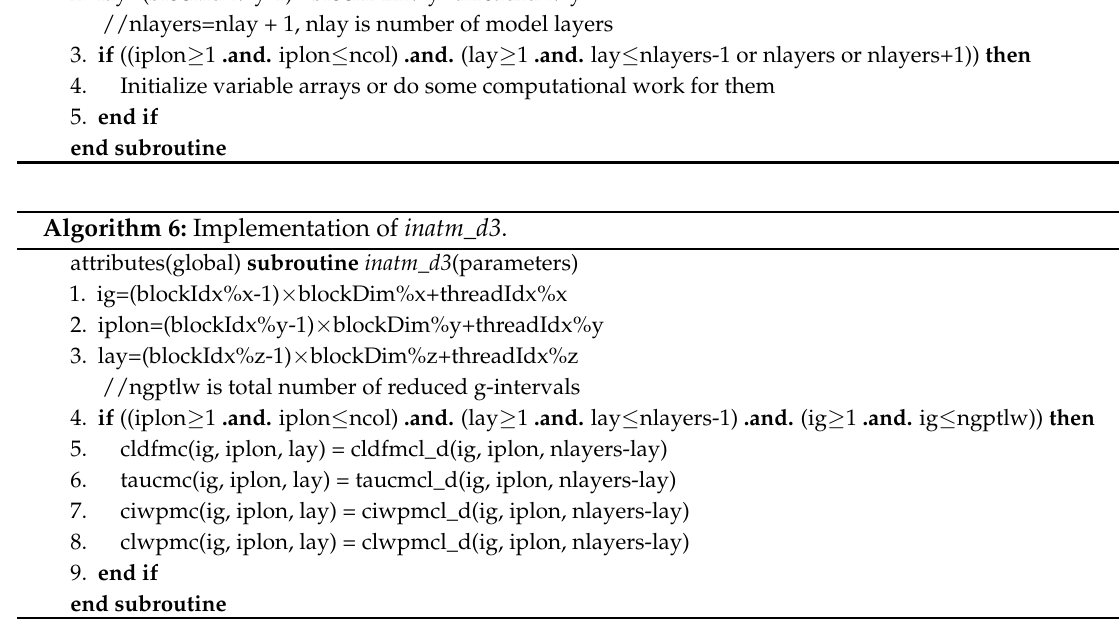
Algorithm 5: Implementation of 2D inatm_d .